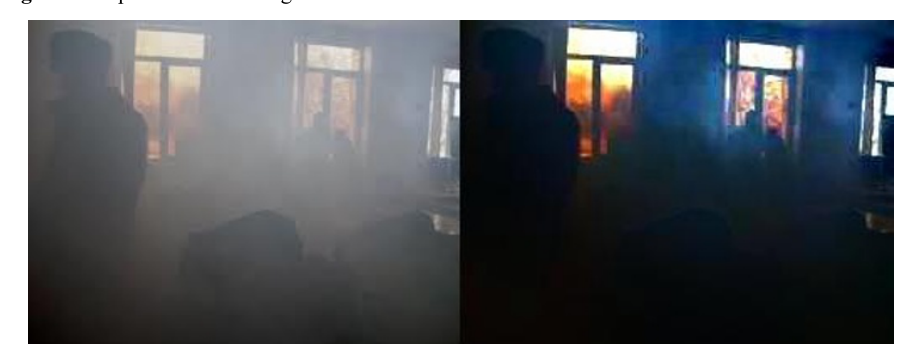
Fig. 9. Example No. 1 of the algorithm.